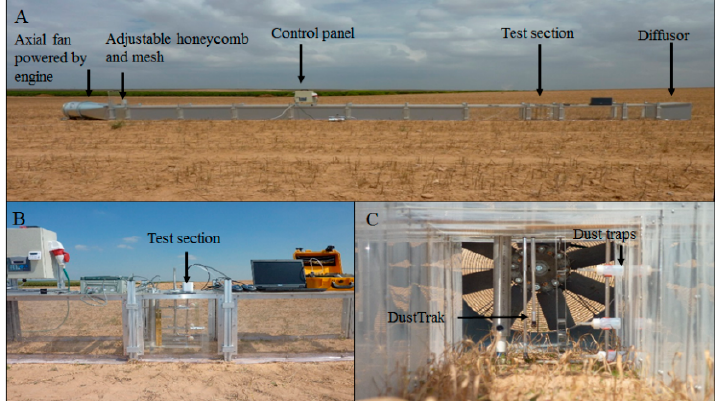
Figure 2. The portable wind tunnel of Ben Gurion University for the field experiments on dust emission processes. ( A ) The tunnel segments are presented in the air-push configuration in an agricultural field. ( B ) Closer view of the wind tunnel test section. ( C ) Instruments installed in the test section (from Tanner et al., 2016